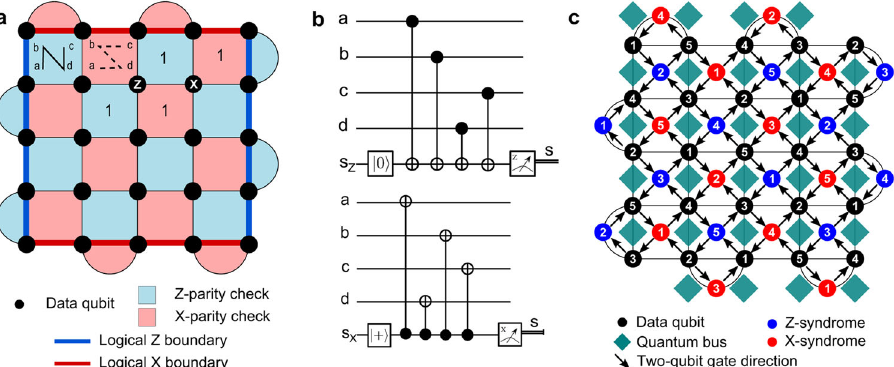
Fig. 3 a The RSC with d 2 data qubits ( black circles ) and the ( d 2 − 1) X - ( red ) and Z -parity ( blue ) checks, shown for d = 5. Examples of errors are shown ( white lettering inside black data qubit circles ) along with the corresponding measured syndromes for surrounding parity checks. Logical operation boundaries are shown for X and Z Pauli operations as red and blue lines, respectively. b The quantum circuits used to perform the Z -parity and X -parity checks. The order of these checks ensures that no hook errors 10 can be incorrectly assigned as single-qubit errors. c A physical realization of the RSC superconducting qubits with quantum buses for mediating interactions. Here, quantum buses are used to connect data qubits to syndrome bits for Z and X parity detection. Furthermore, a proposed arrangement of fi ve distinct qubit frequencies (numbering within the qubits) is shown to minimize crosstalk and addressability errors.